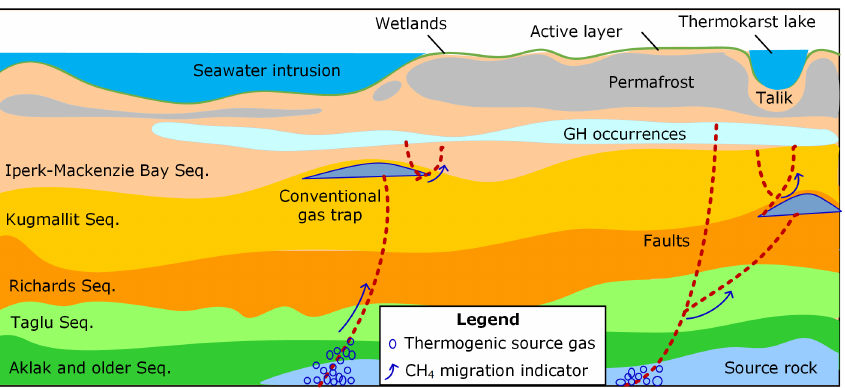
Figure 1. Illustration of the GH-associated permafrost lowlands along the Arctic coastal plain of the Beaufort Sea, according to Chen et al. [17]. A portion of the plain has been inundated by sea by thawing continental ice sheets at high northern latitudes. The thermogenic gaseous CH 4 migrates along the faults (red dashed lines) from deeper geological units (i.e., source rock) and accumulates in the upper sequences (e.g., Kugmallit–Richards Seq., Seq. = sequence, not to scale), which